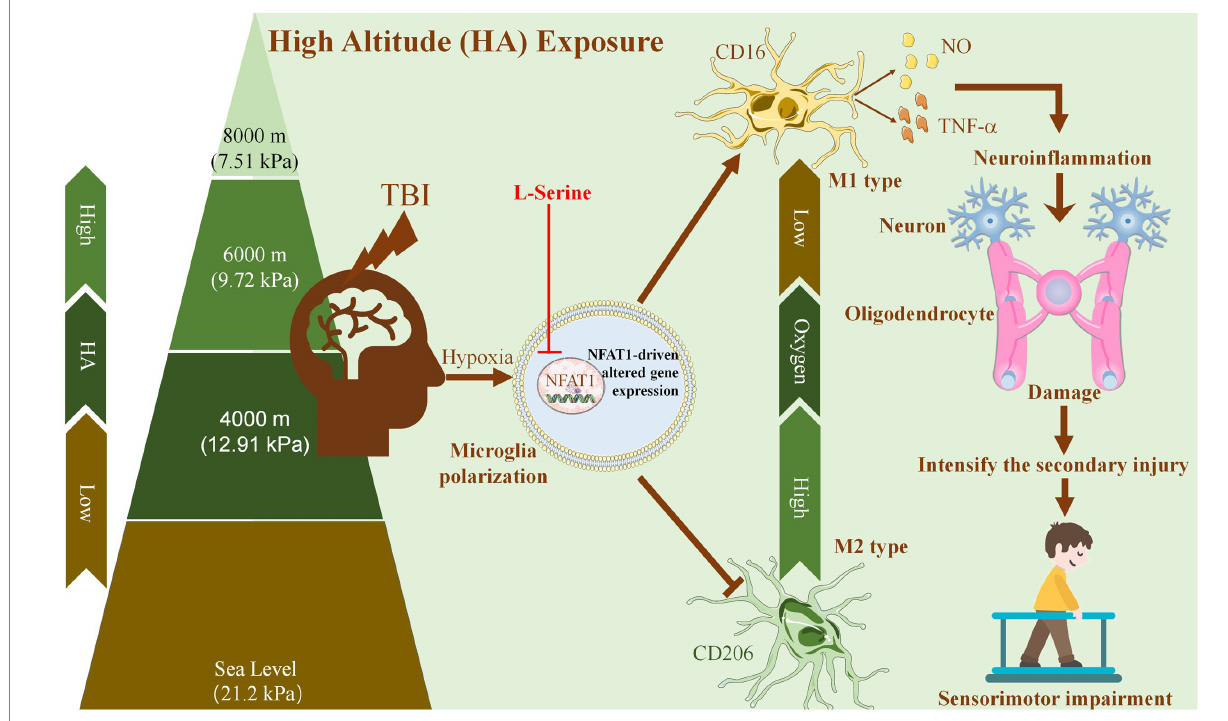
FIGURE 8 Proposed mechanism underlying the neuroprotective effects of L-serine against traumatic brain injury at high altitude. With increasing altitude, the oxygen partial pressure in the air decreases gradually. HA enhances the activation of microglia and promotes microglial polarization toward the proinflammatory M1 phenotype. HA exposure aggravates neuroinflammation after TBI, which causes injury to neurons and oligodendrocytes around the initial injury area, further aggravates secondary injury to the sensorimotor cortex and white matter, and leads to the deterioration of sensorimotor function. As an endogenous amino acid, L-serine may promote the polarization of microglia to the M2 phenotype and inhibit neuroinflammation by downregulating the transcription factor NFAT1, thus playing a neuroprotective role after HA-TBI and improving sensorimotor